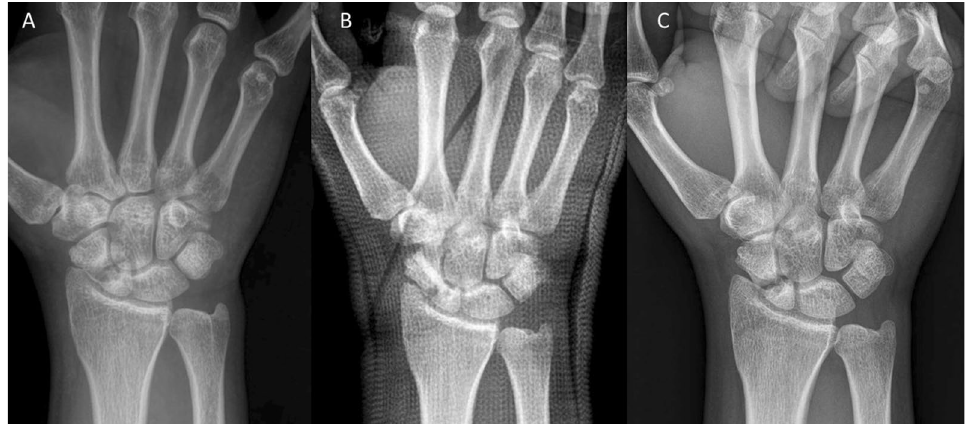
Fig. 7 Example of nonunion. The patient had pseudarthrosis of the scaphoid in the middle third. A Pre-surgery. B 6 weeks post-surgery. The screw was not placed deep enough into the proximal pole. C 16 months post-surgery. The screw was fully integrated in the bone, but union was not achieved. Re-operation is scheduled